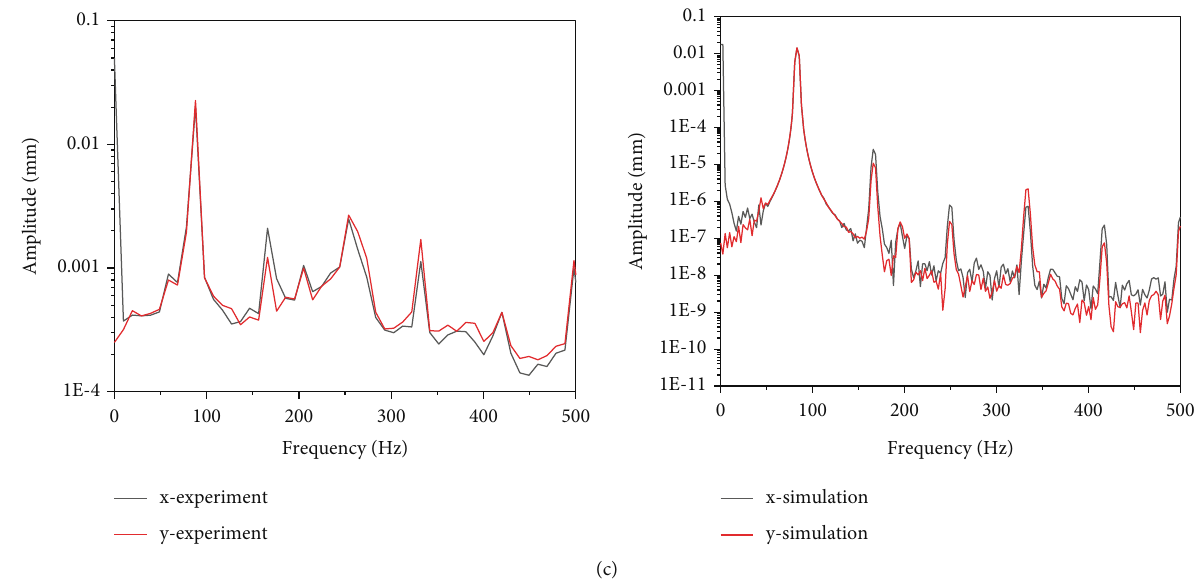
Figure 16: Spectrogram of the shaft for case 6. (a) Subcritical speed. (b) Critical speed. (c) Supercritical